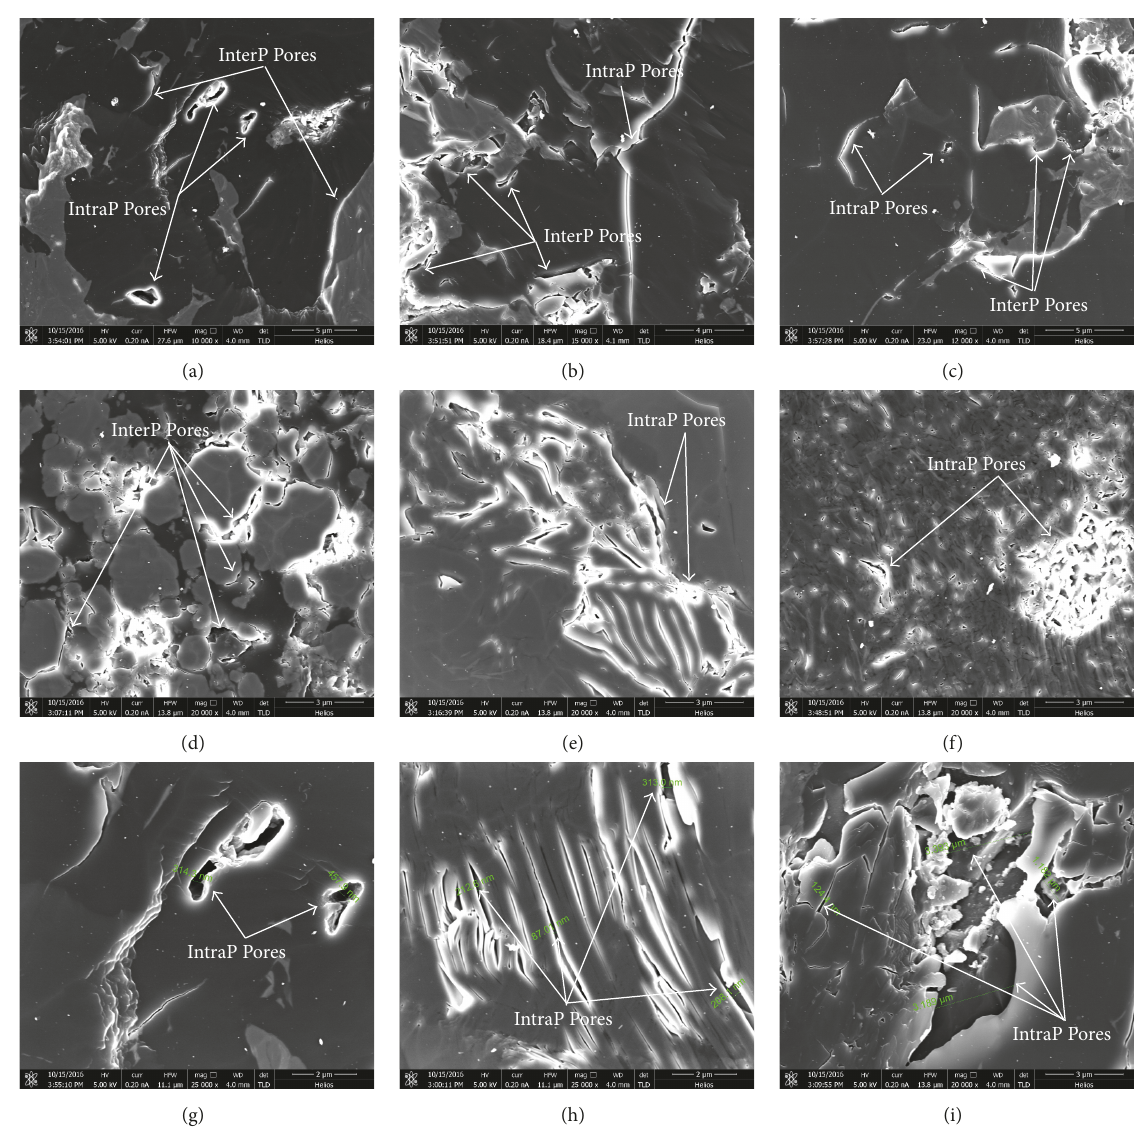
= 1.78%; 𝐾 𝑔 = 0.0003 mD). Avg